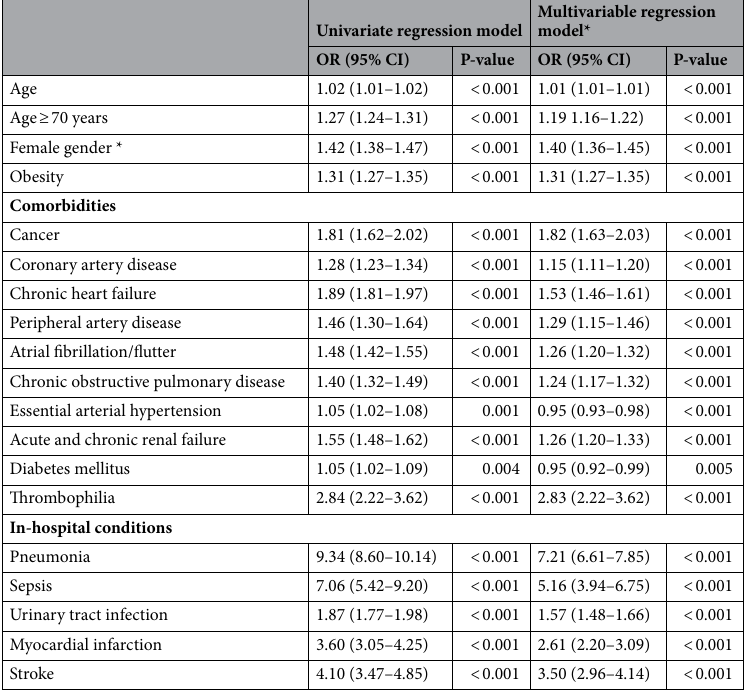
Table 2. Association of patients’ characteristics and in-hospital events with occurrence of VTE (univariate and multivariable logistic regression models). *Adjusted for age, sex, obesity, cancer, coronary artery disease, heart failure, atrial fibrillation/flutter, arterial hypertension, chronic obstructive pulmonary disease, acute and chronic renal failure, and diabetes mellitus.